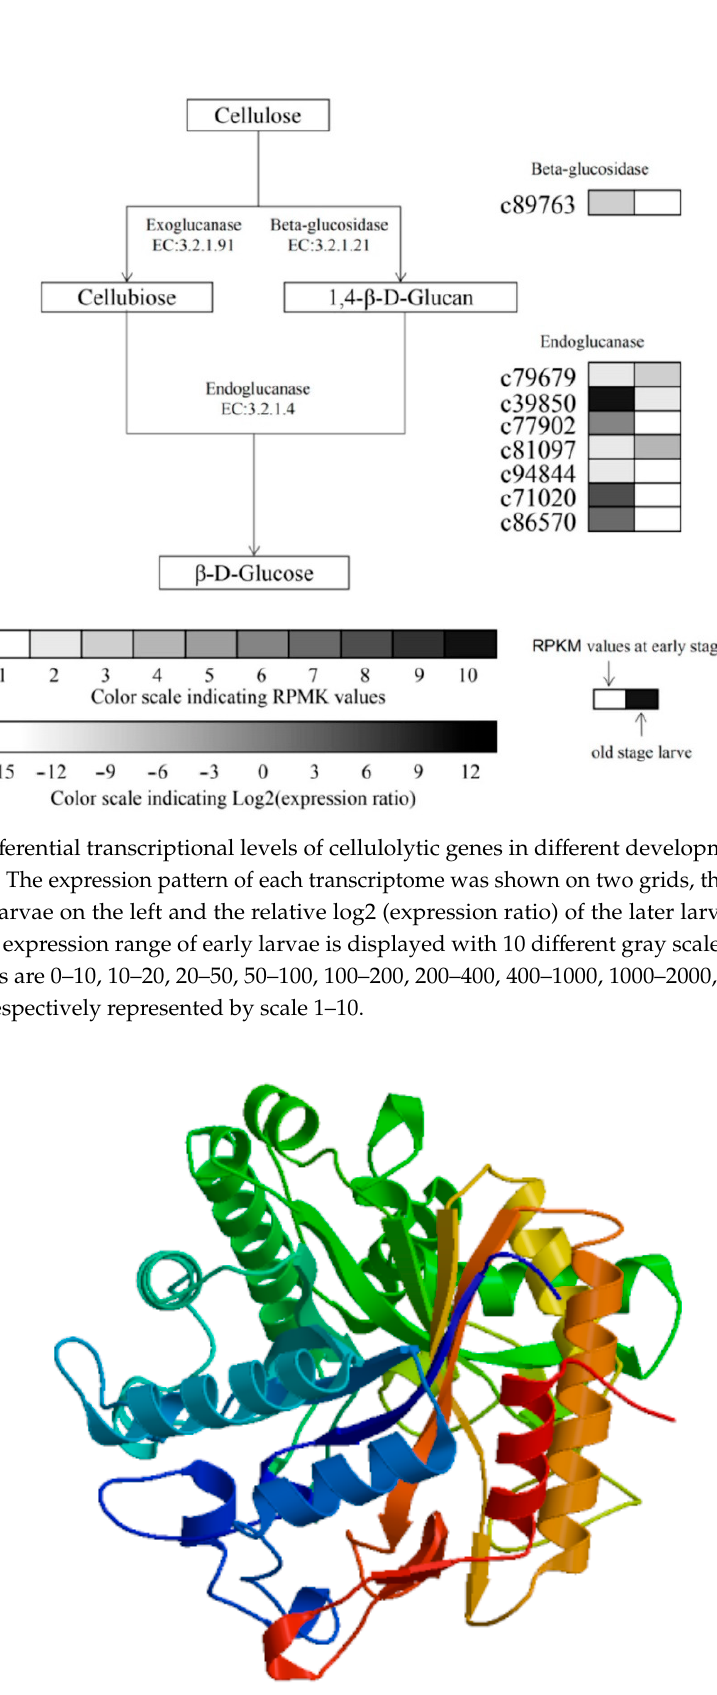
Figure 2. Prediction of MaCel1 protein tertiary structure.